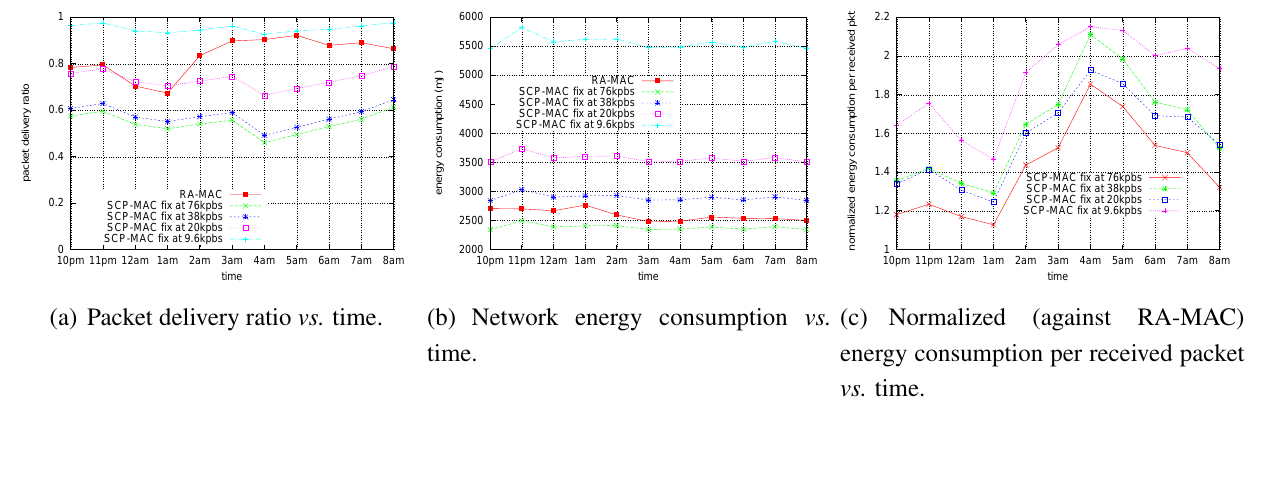
Figure 6 . One segment of the transmission data rate value